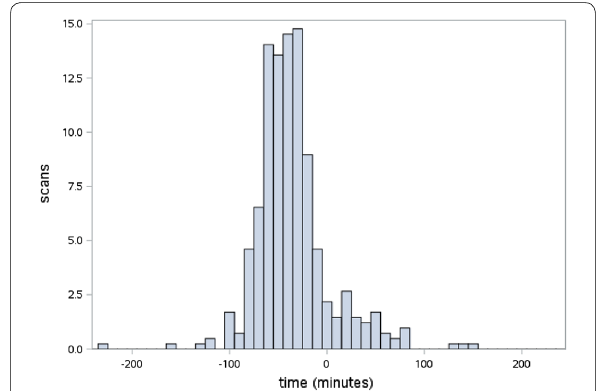
Fig. 2 Time distribution of POCUS to formal imaging (time 0 time of PoCUS = −